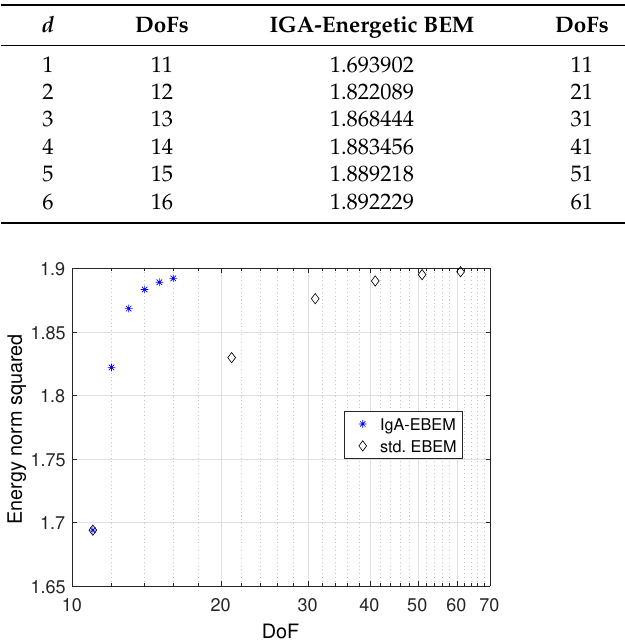
Figure 5. Squared space-time energy norm (60) of the IGA- and standard Energetic BEM approximate transient solutions, for increasing degree d , plotted with regard to DoFs.